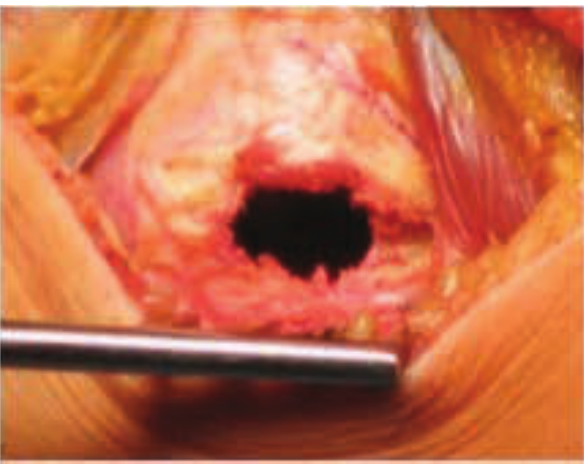
Figure 4: Intraoperative view after curattage of a large lesion of the Gaucher disease of the distal part of